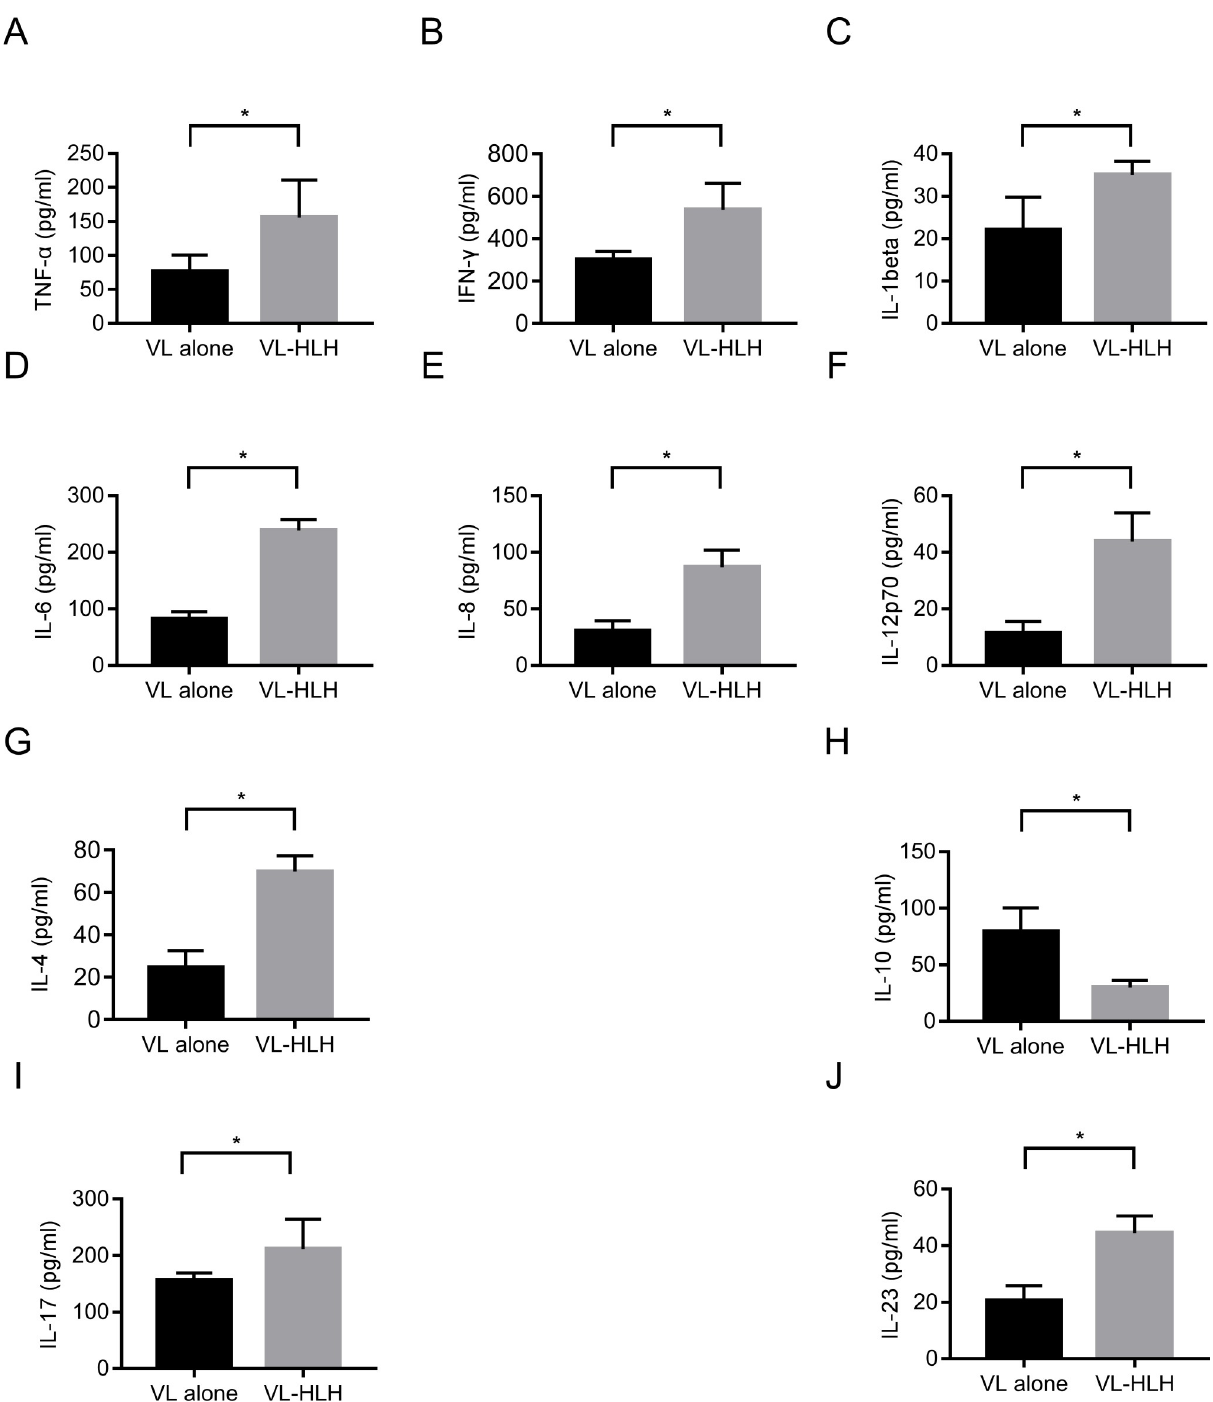
Fig 2. Sera cytokines measurement in the VL and VL associated HLH groups. Cytokines were measured by Luminex assay in sera of VL (n = 27) and VL associated HLH (n = 17) patients. (A) TNF- α , (B) IFN- γ , (C) IL-1beta, (D) IL-6, (E) IL-8, (F) IL-12p70, (G) IL-4, (H) IL-10, (I) IL-17 and (J) IL-23. Data are mean ± SD of three independent experiments, P < 0.05 between two groups.